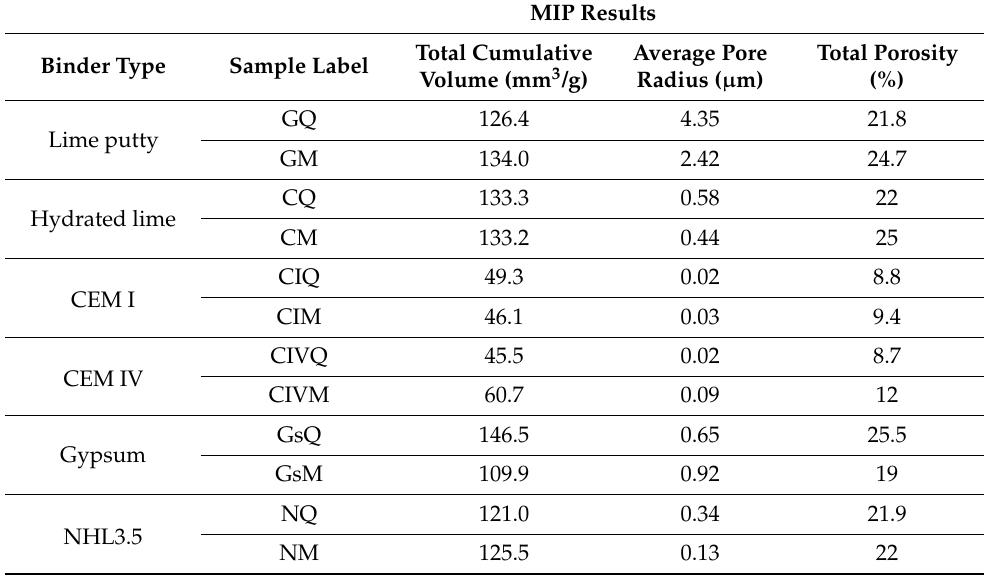
Table 2. Results of the MIP analysis. (Note that “M” is the abbreviation for crushed limestone aggregate while “Q” is the abbreviation for quartz